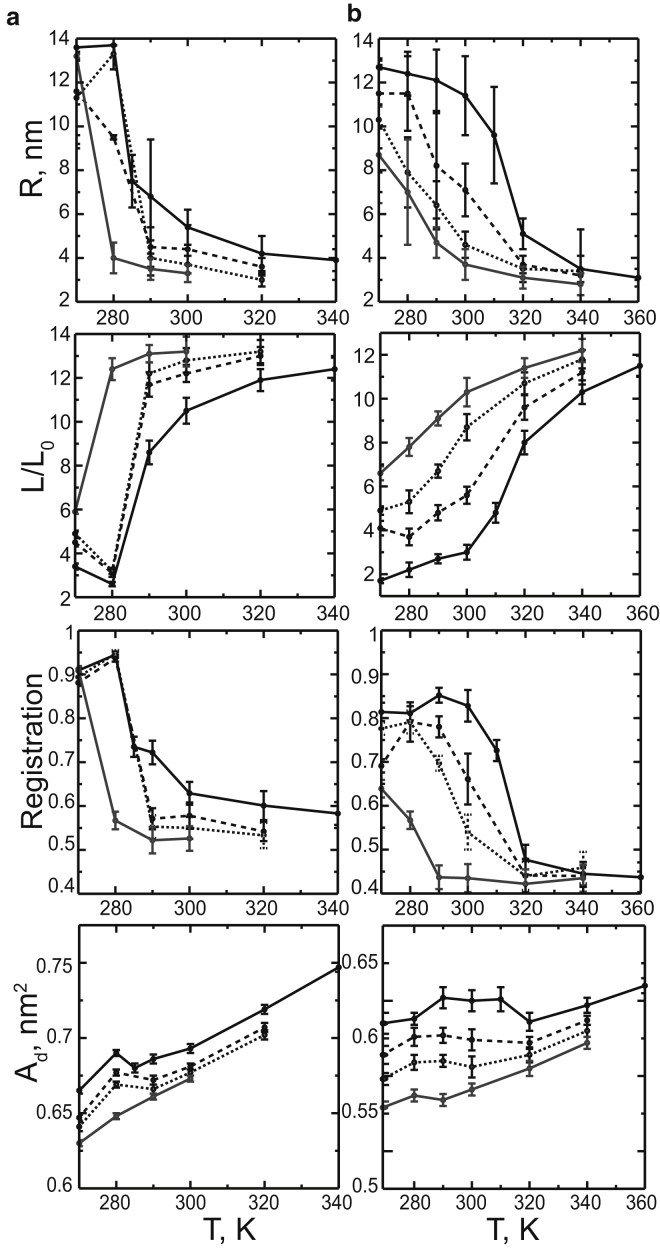
Differences in properties between domains and fluctuations for the DPPC/DUPC 3:2 (a) and DPPC/DUPC/cholesterol 7:7:6 (b) small bilayers are shown. The molar percentage of PUPC substituting DUPC is shown as follows: 0%, 20%, 30%, 40% in (a) or 0%, 14%, 29%, 43% in (b) as solid black, dashed black, dotted black, and solid gray, respectively. The horizontal panels show the following properties as a function of temperature, T: R, radius of the ordered clusters; L, boundary length of the ordered clusters (normalized by the perimeter of a circular cluster of the same area); overlap (registration) of the ordered clusters between the two leaflets; and Ad, average area per lipid, in the disordered clusters (composition fluctuations or domains of the more disordered phase, Lα or Ld).